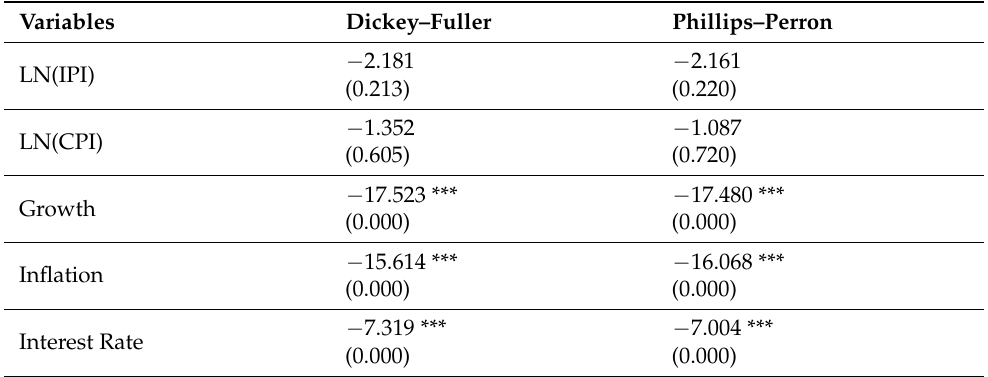
Table 2. Unit root